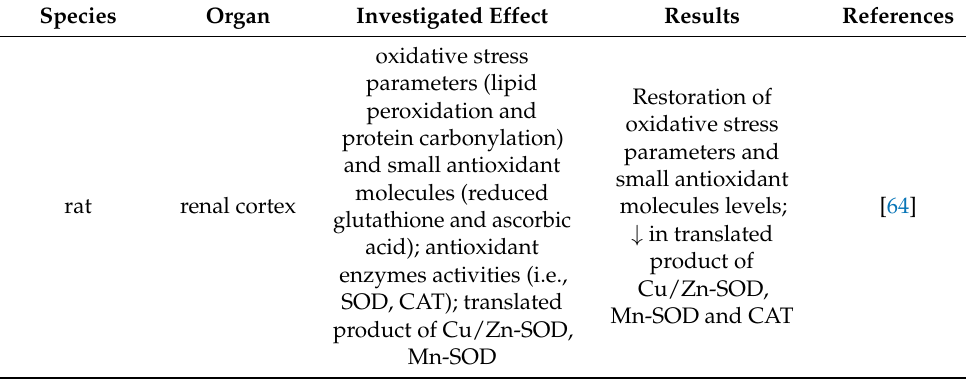
Table 7. Vitamin E effects on selected parameters of hyperthyroid-induced animal